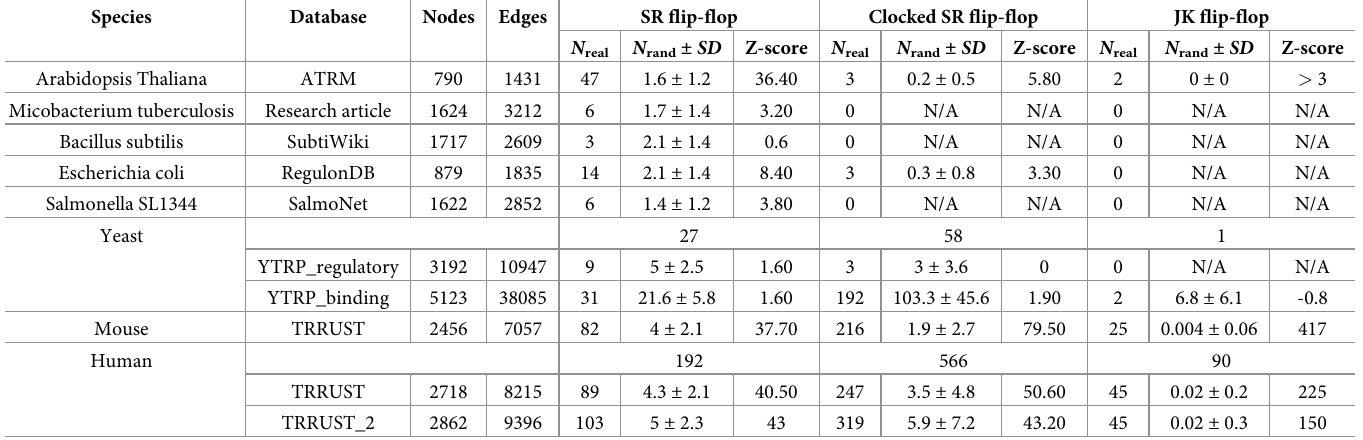
In this last case, the SR flip-flop stores Q = 0 and � Q ¼ 1 , which is also remembered when both inputs are high ( S = 1 and R = 1, S1 File Section IV B). This spontaneous symmetry breaking [34] has analogy with a ferromagnetic material. When the temperature is high enough, the ferromagnet does not show any magnetic property. Moreover, even lowering the temperature, in absence of any polarizing field, the material does not magnetize. On the contrary, if an external magnetic field is applied to the ferromagnet, like a magnet put in contact to a needle for enough time, and then removed, then the needle becomes magnetic itself, in that it remembers the direction of the previously applied magnetic field, thus breaking, spontaneously, the rotational symmetry. Biological realizations of this replica symmetry breaking process are shown in Fig 4, last row. Full list of symmetry broken circuits in gene regulatory networks across species appears in S1 File Section V and S2 File. Table 2 shows the Z-scores of these circuits indicating their significance. The algorithm to identify these broken symmetry flip-flops in biological networks is developed in S1 File Section VII and is available at https://github.com/makselab/CircuitFinder. Extending this duplication and symmetry breaking process to the FFF (Fig 4, second col- umn), one can replicate the X and Y genes from the FFF base to create a circuit isomorphic to the Clocked SR flip-flop, another computer memory building block [33] (see S1 File Section IV B). The symmetry is broken by regulators or inducers of genes X and X’ acting as S (set) and R (reset) of memory, and it is restored when S = R, leaving the system ‘magnetized’. The hierarchy continues by replicating the Fibonacci Fiber and consequent breaking of symmetry when the inputs J and K are different (Fig 4 third column, see S1 File Section IV B). This struc- ture is isomorphic (i.e., has the same base ) to the JK flip-flop in electronics, which is the most widely used of all flip-flop designs [33]. In its symmetric state, the JK flip-flop is isomorphic to the symmetric Fibonacci base . In the symmetry broken phase, it acts as a memory device which presents two possibilities. A ‘chiral’ symmetry (where Y feeds X and Y’ feeds X’) and a Table 2. Broken symmetry circuits count.